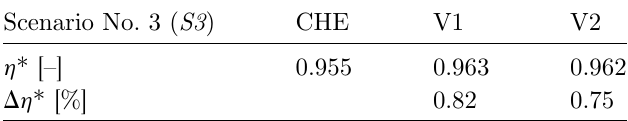
Table 4. The weighted hydraulic ef fi ciency for each solution and the ef fi ciency gain with respect to the existing one in scenario No. 3 ( S3 ).